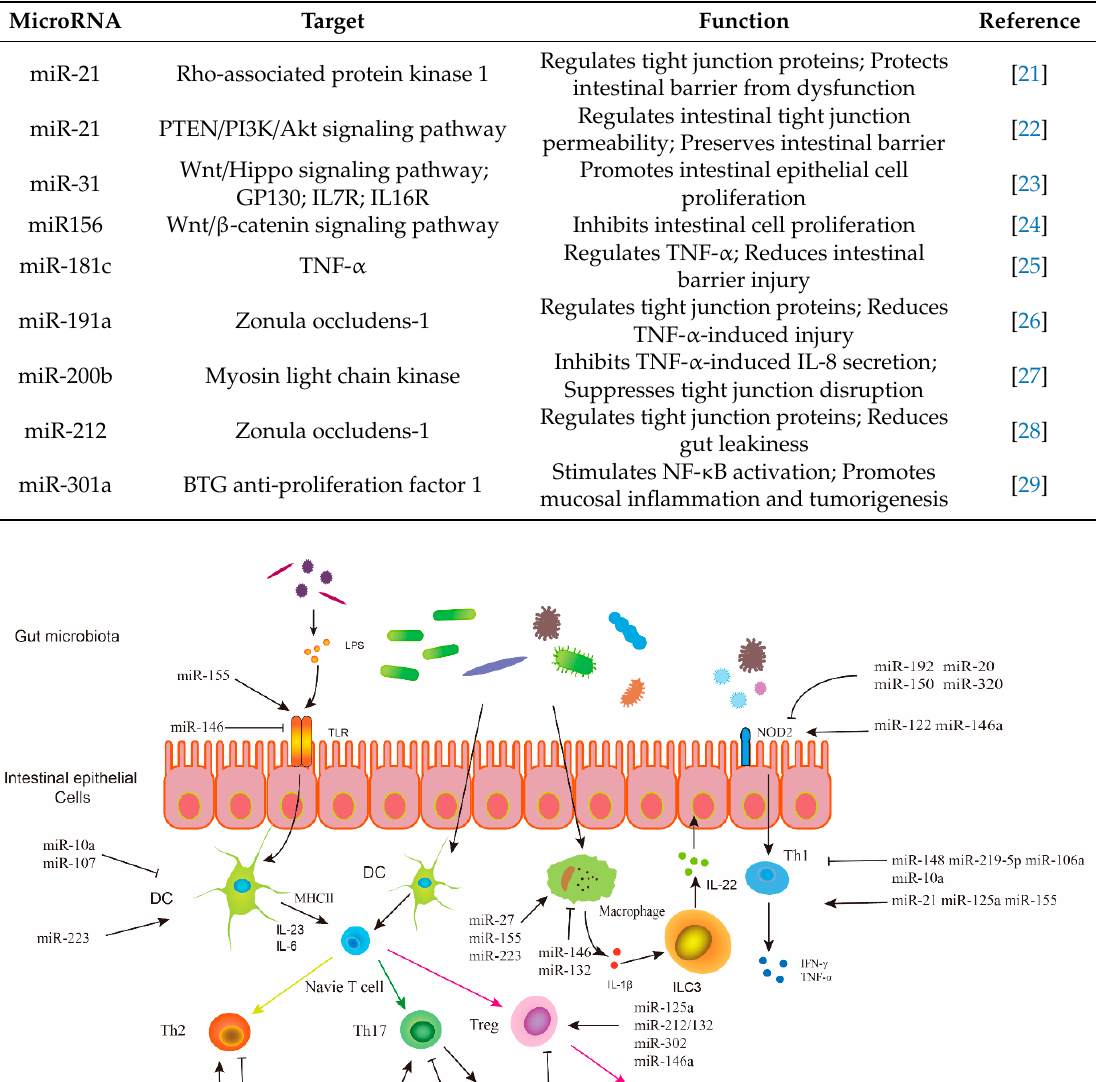
Table 1. Representative microRNAs and their functions in gut intestine.